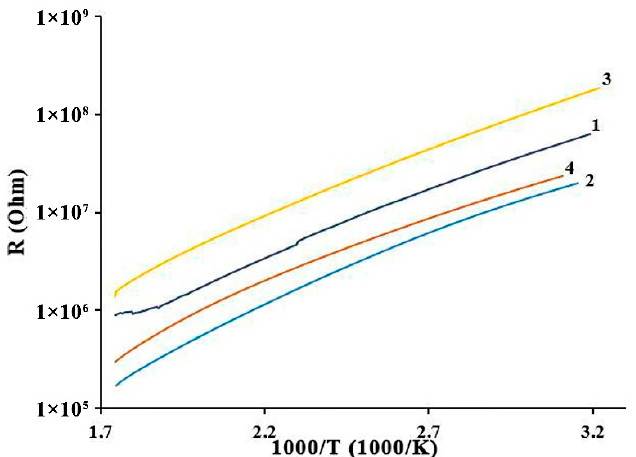
Figure 4. Dependence of resistance (R) on the operating temperature (T) of samples ZnO/ SnO 2 (1) (1), ZnO/ SnO 2 (2) (2), ZnO/Au(1) (3) and ZnO/Au(2) (4) NRs. (1), ZnO/SnO 2 (2) (2), ZnO/Au(1) (3) and ZnO/Au(2) (4)